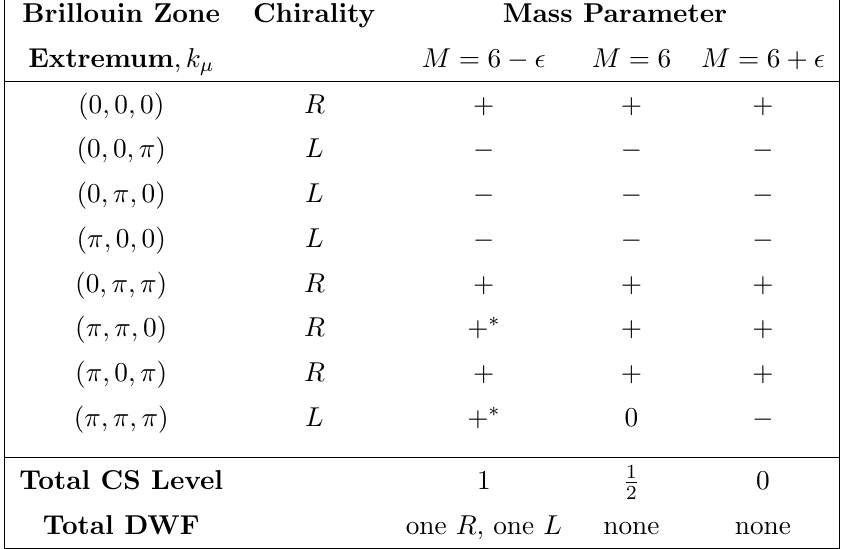
Table 3 . Chirality, mass, and existence of a DWF for the eight modes at the extremum of the Brillouin zone, k (cid:22) = ( k t ; k x ; k y ), as calculated using eqs. (5.10) and (5.12). Positive and negative masses are denoted by a + and (cid:0) , respectively and an astrix denotes a mode which meets the condition to be a